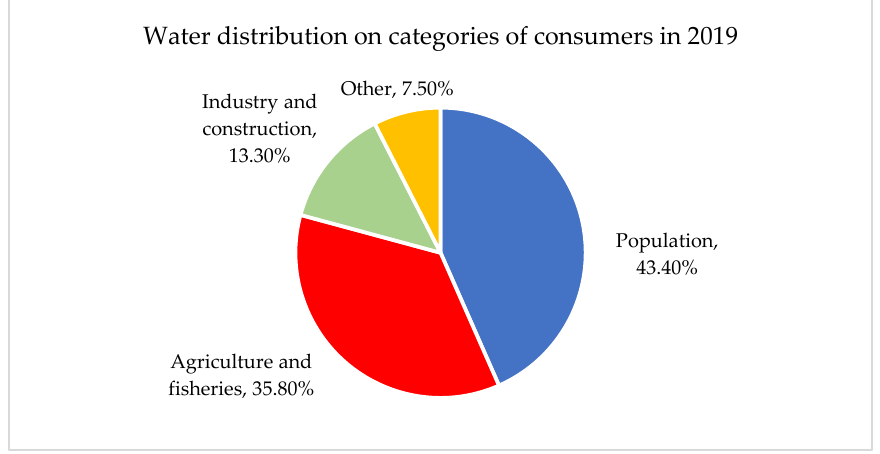
Figure A5. Water distribution based on categories of consumers in 2019, Romania. Source: https://insse.ro/cms/sites/default/files/com_presa/com_pdf/distributia_apei20r.pdf (accessed on 27 May 2021).